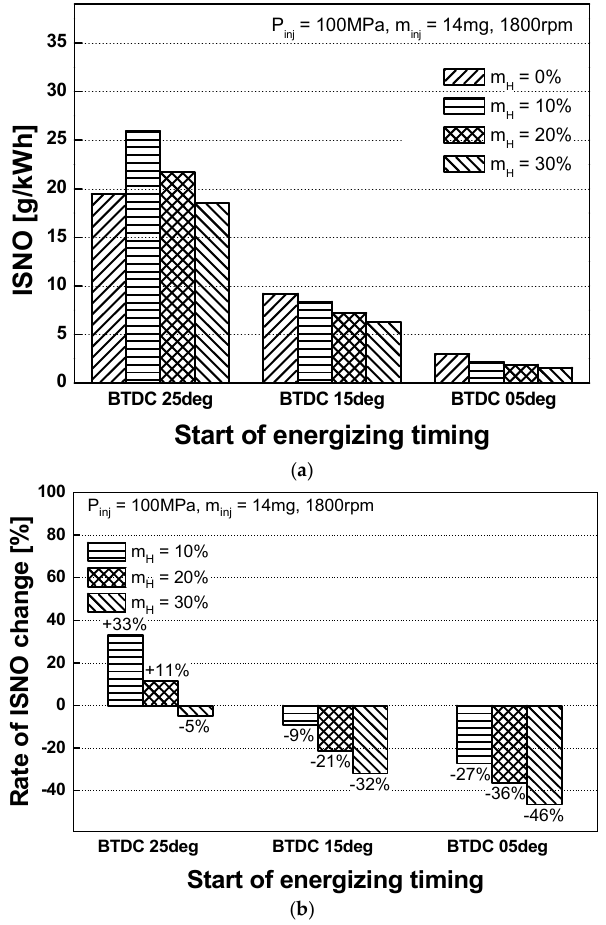
Figure 9. Effect of water vapor portion on the ISNO characteristics under different starts for energizing timing (P inj = 100 MPa, m inj = 14 mg, 1800 rpm). ( a ) ISNO characteristics and ( b ) rate of ISNO change.